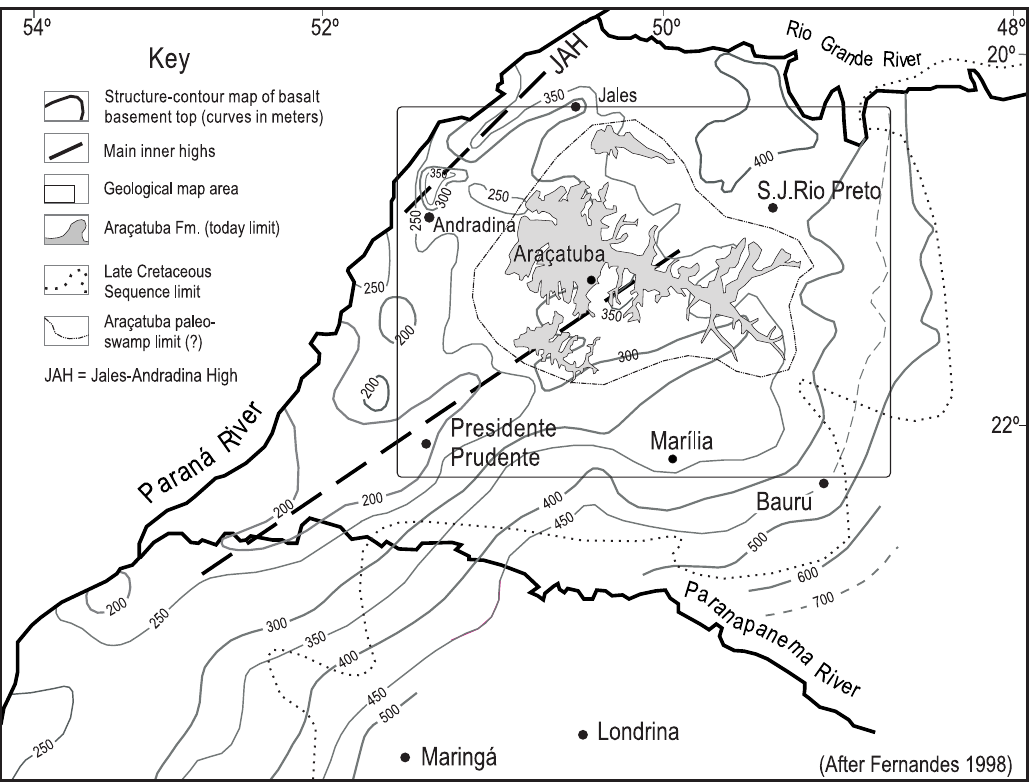
Fig. 7 – Map of the top of Serra Geral Formation: the Bauru Basin basement. TheAraçatuba depressed zone and its westernmost limit parallel the Jales-Andradina High